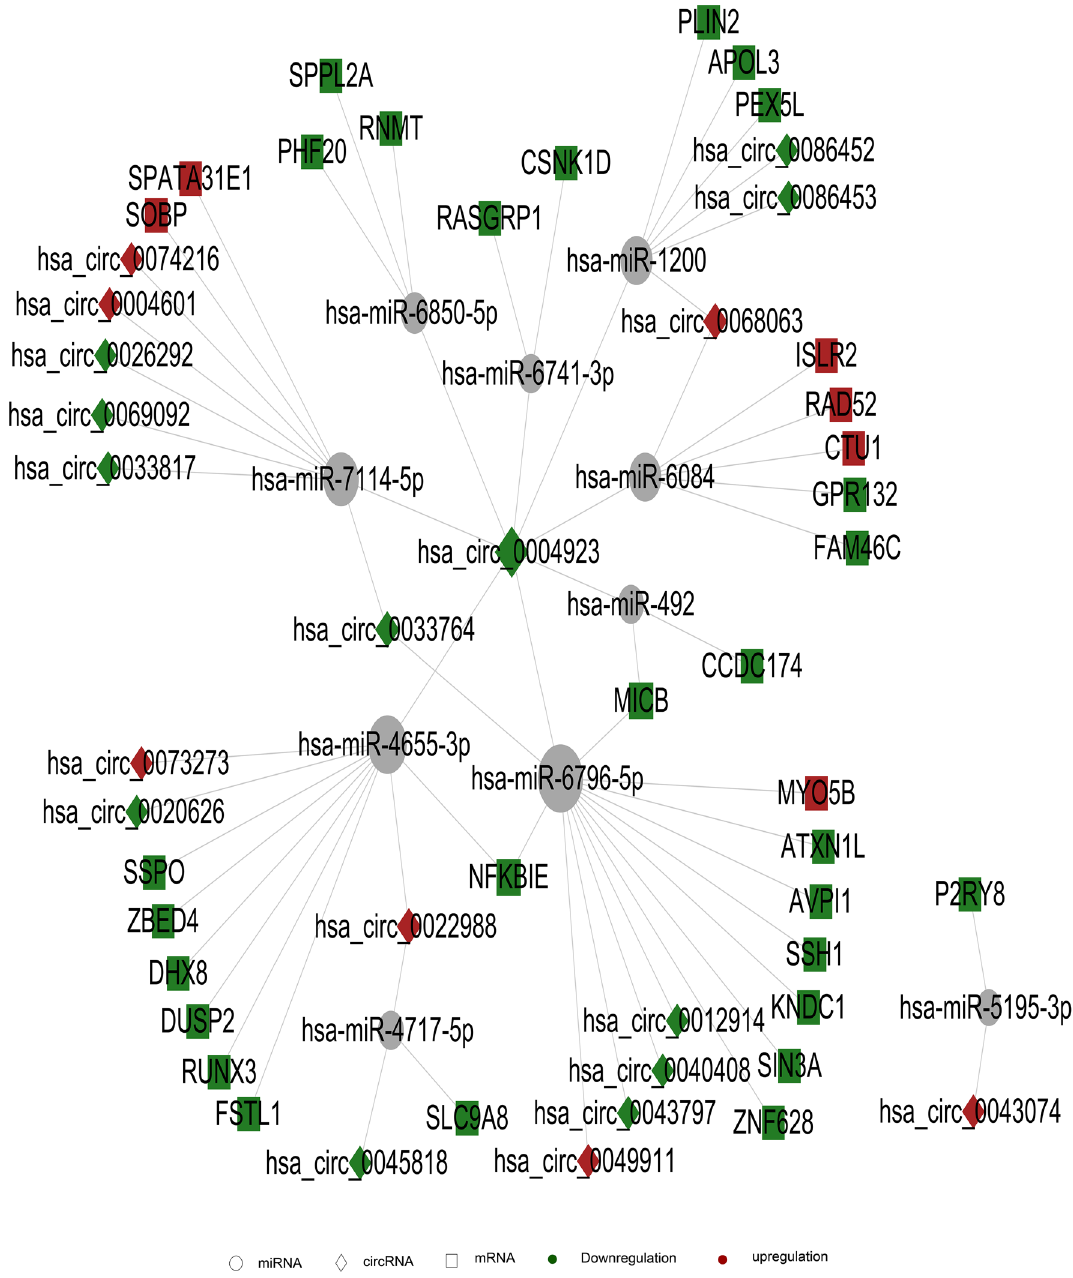
Figure 8. ceRNA analysis results of circRNA. Rectangle represents circRNA, square represents mRNA, circle represents miRNA; red represents up-regulation and green represents down-regulation. Each dot in the network represents a gene, the lines represent microRNA that are regulated between genes. The size of the circle represents the gene’s ability to interact with other genes. We use degree to quantify it, and the larger the degree, the more genes interact with other genes. Based on the degree of each gene in the gene synergy network, key genes in the network can be obtained. Samples are from 3 recurrent COVID-19 patients and 3 healthy